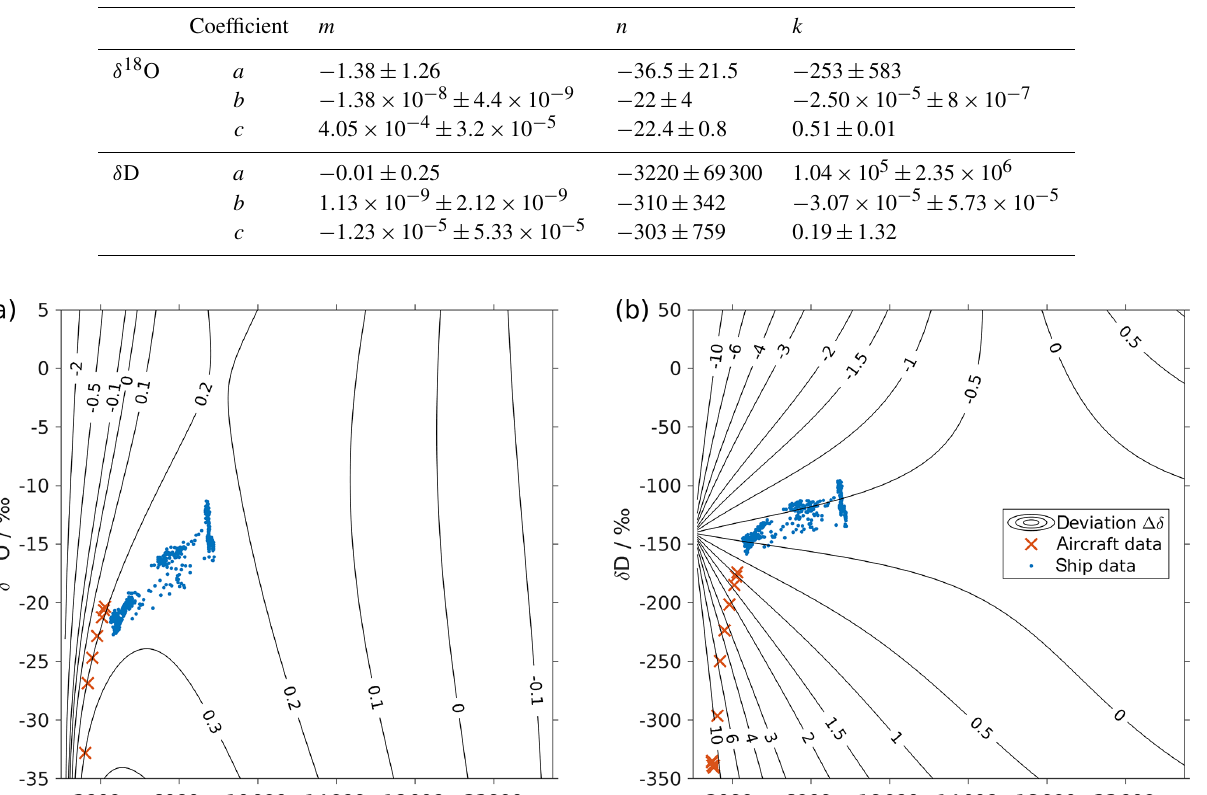
Table 5. Fitting coefficients for the isotope composition dependency of the mixing ratio dependency coefficients a,b , and c in Table 4. Coefficients m,n , and k are with respect to the fitting function f j (δ) = m j (δ − n j ) 2 + k j . The reported uncertainty is 1 standard deviation. The fitting lines are shown in Fig. 2.